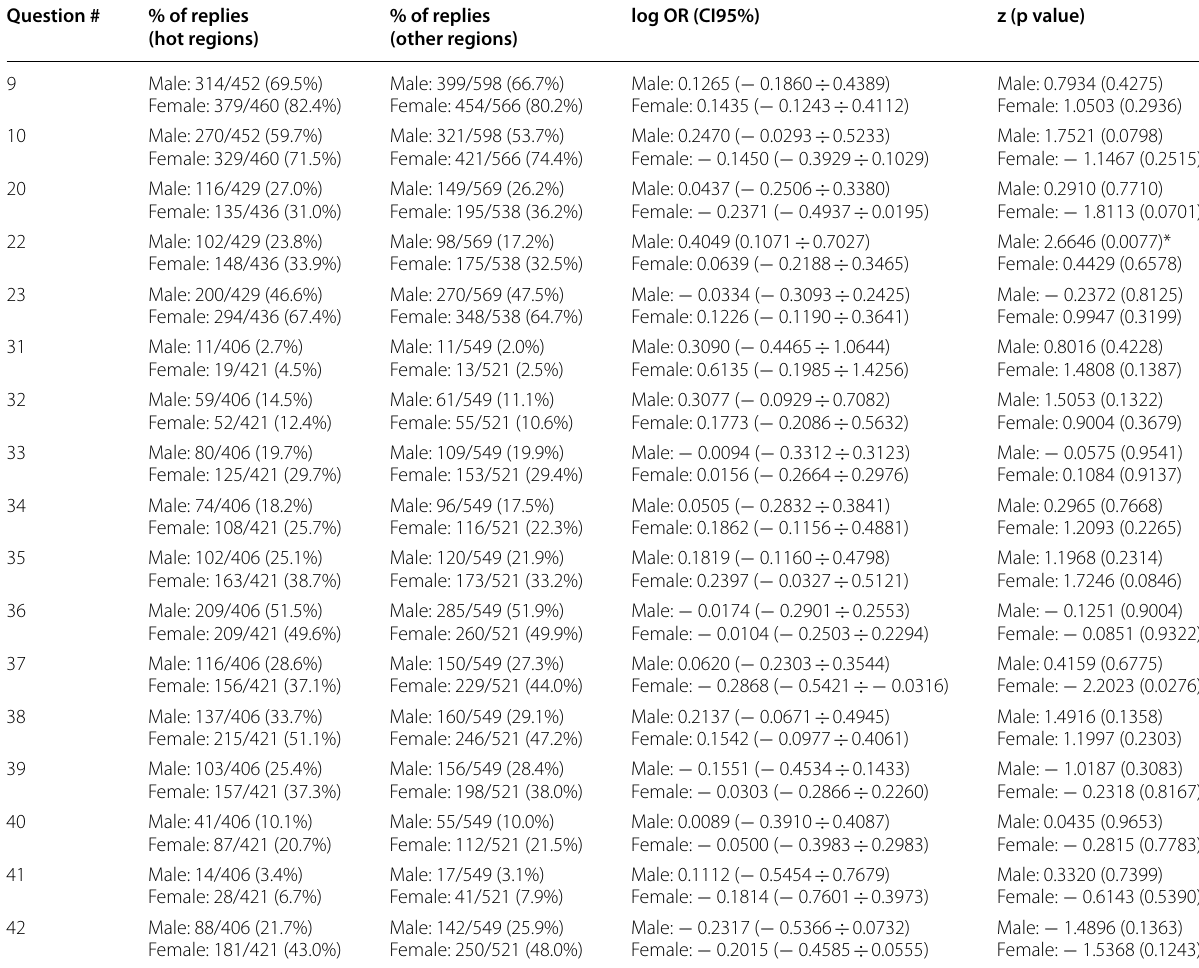
Table 2 Distribution of answers in hot and other regions stratified by respondents’